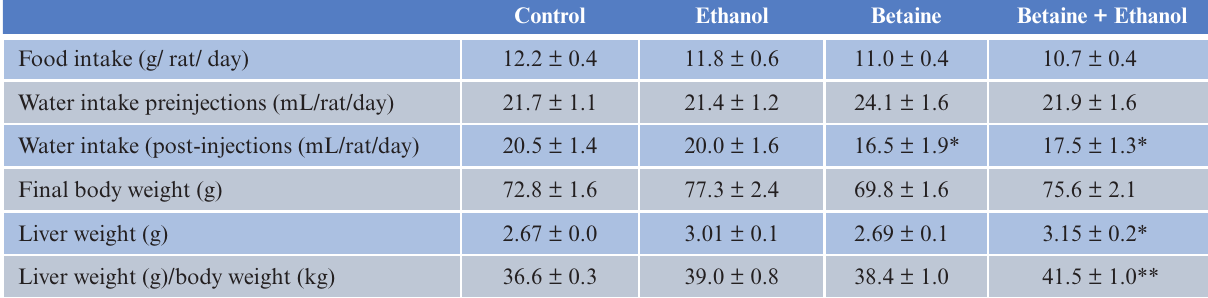
Table 1: The effect of betaine on food and water intake, body weights, and liver